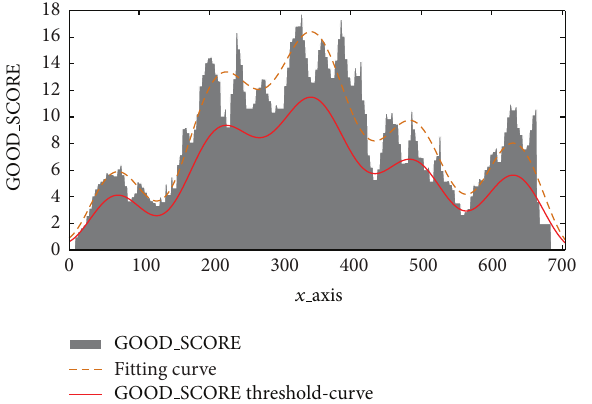
Figure 17: GOOD SCORE threshold-curve figure (see (8)).